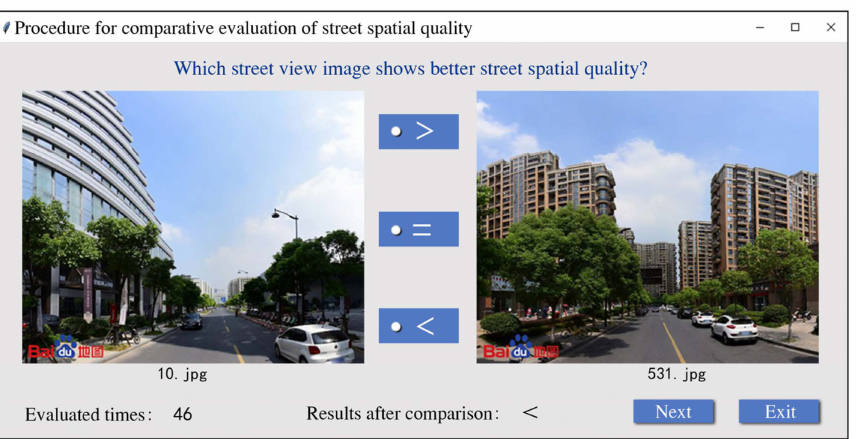
Figure 6. Comparison and evaluation procedure of street spatial